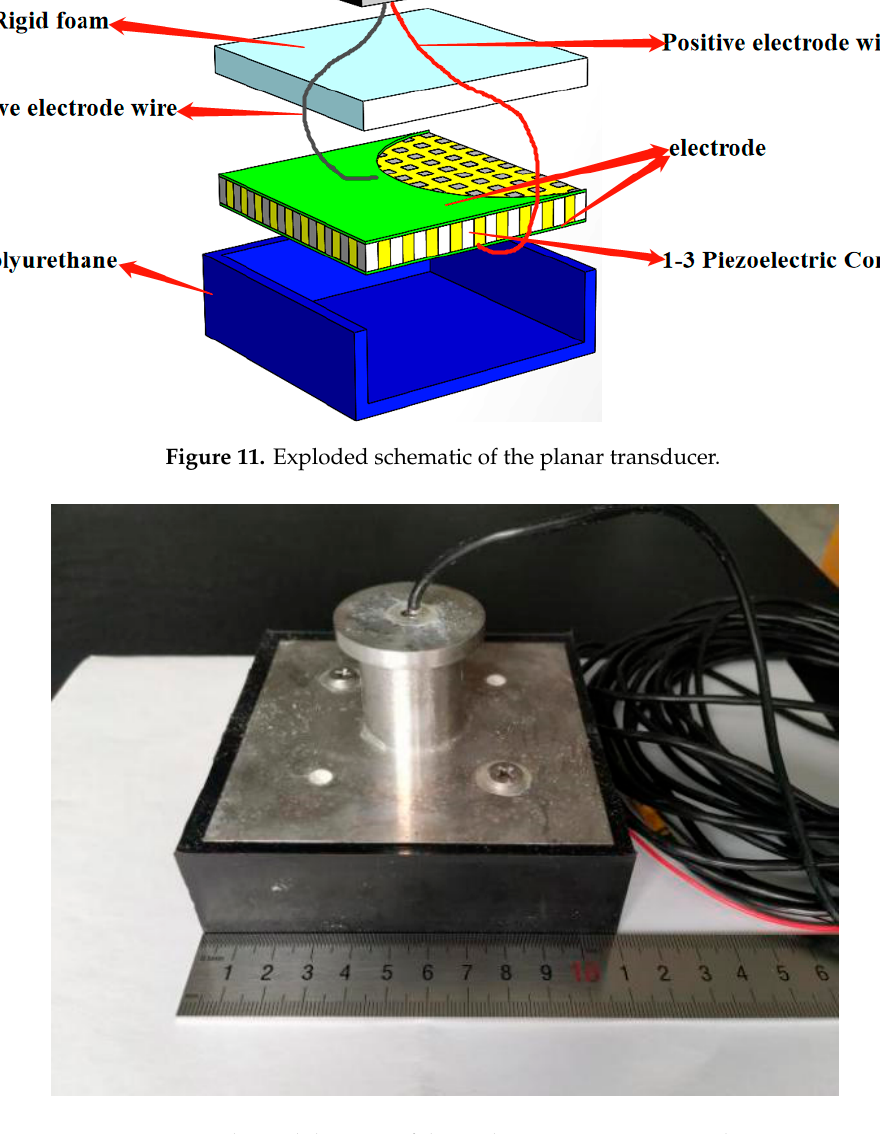
Figure 11. Exploded schematic of the planar transducer.